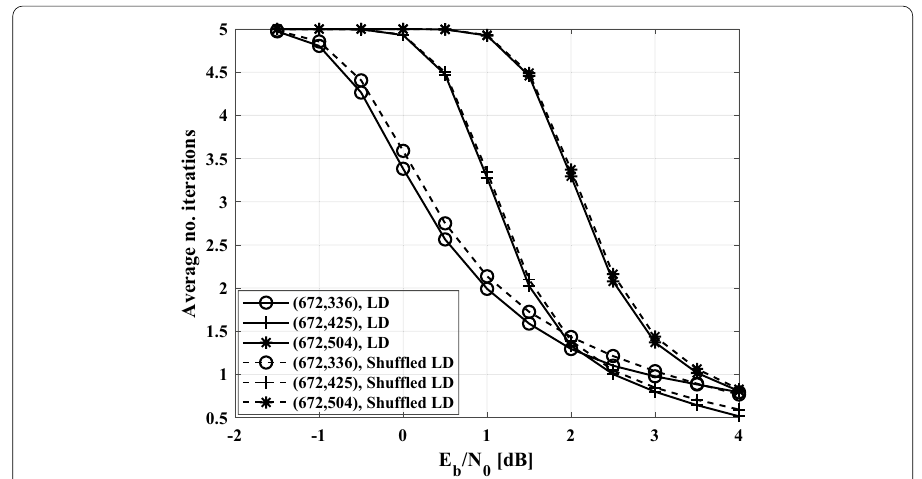
Fig. 10 Average number of sub-iterations required for achieving the BER performance of Fig. 9